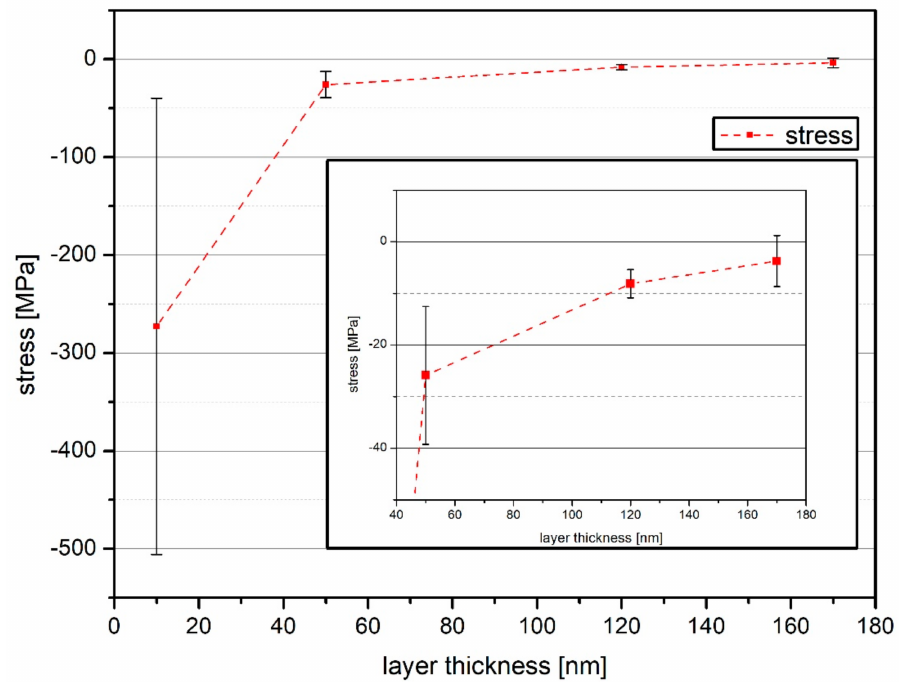
Figure 2. Calculated compressive stress for a-C:H layers with thicknesses from 10–170 nm on PHB (the dashed line only indicates a trend). The region for the later depositions is enlarged (inset) for better